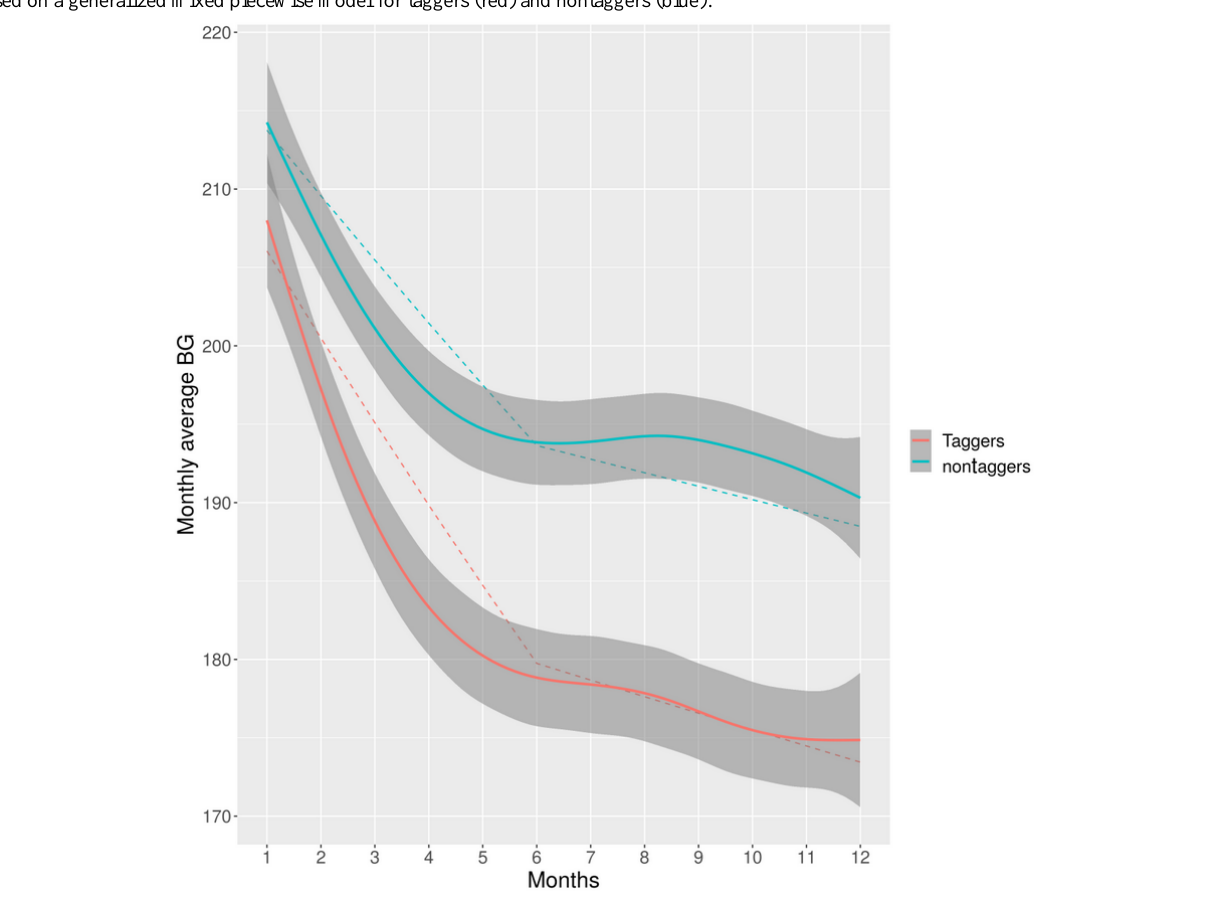
Figure 2. Differences in time-related monthly average blood glucose (BG) (mg/dL) trajectories between taggers and nontaggers. The figure presents locally weighted smoothed monthly average blood glucose data with 95% confidence intervals (the dark grey area surrounding each curve) and predictions based on a generalized mixed piecewise model for taggers (red) and nontaggers